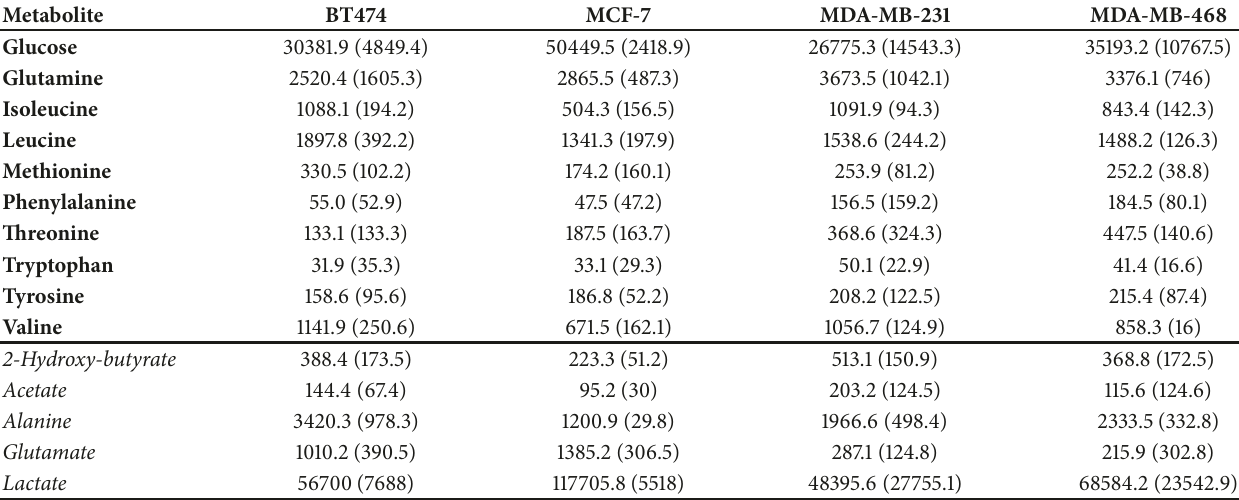
Table 2: Metabolite consumption and production in conditioned